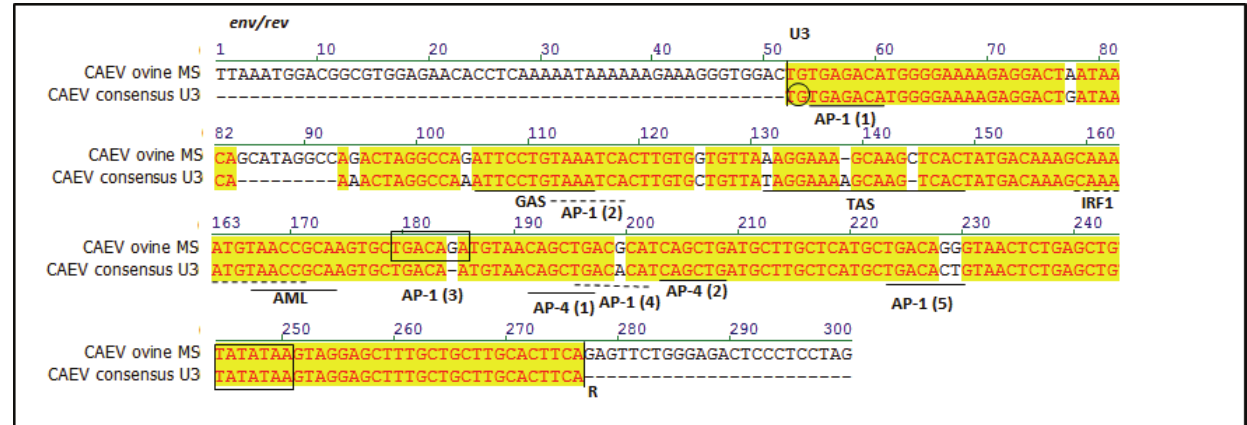
Figure 3. Sequence line-up of the CAEV U3 sequences derived from all the CAEV-infected ovine tissues (CAEV-ovine-MS, top) compared to the CAEV U3 consensus sequence derived from previously reported CAEV isolates in Northern California (CAEV consensus U3, bottom). Transcription factor binding sites are labeled and defined by solid/dotted bars below the pertinent nucleotides. The TATA box and third AP-1 sites are boxed and the invariant TG is